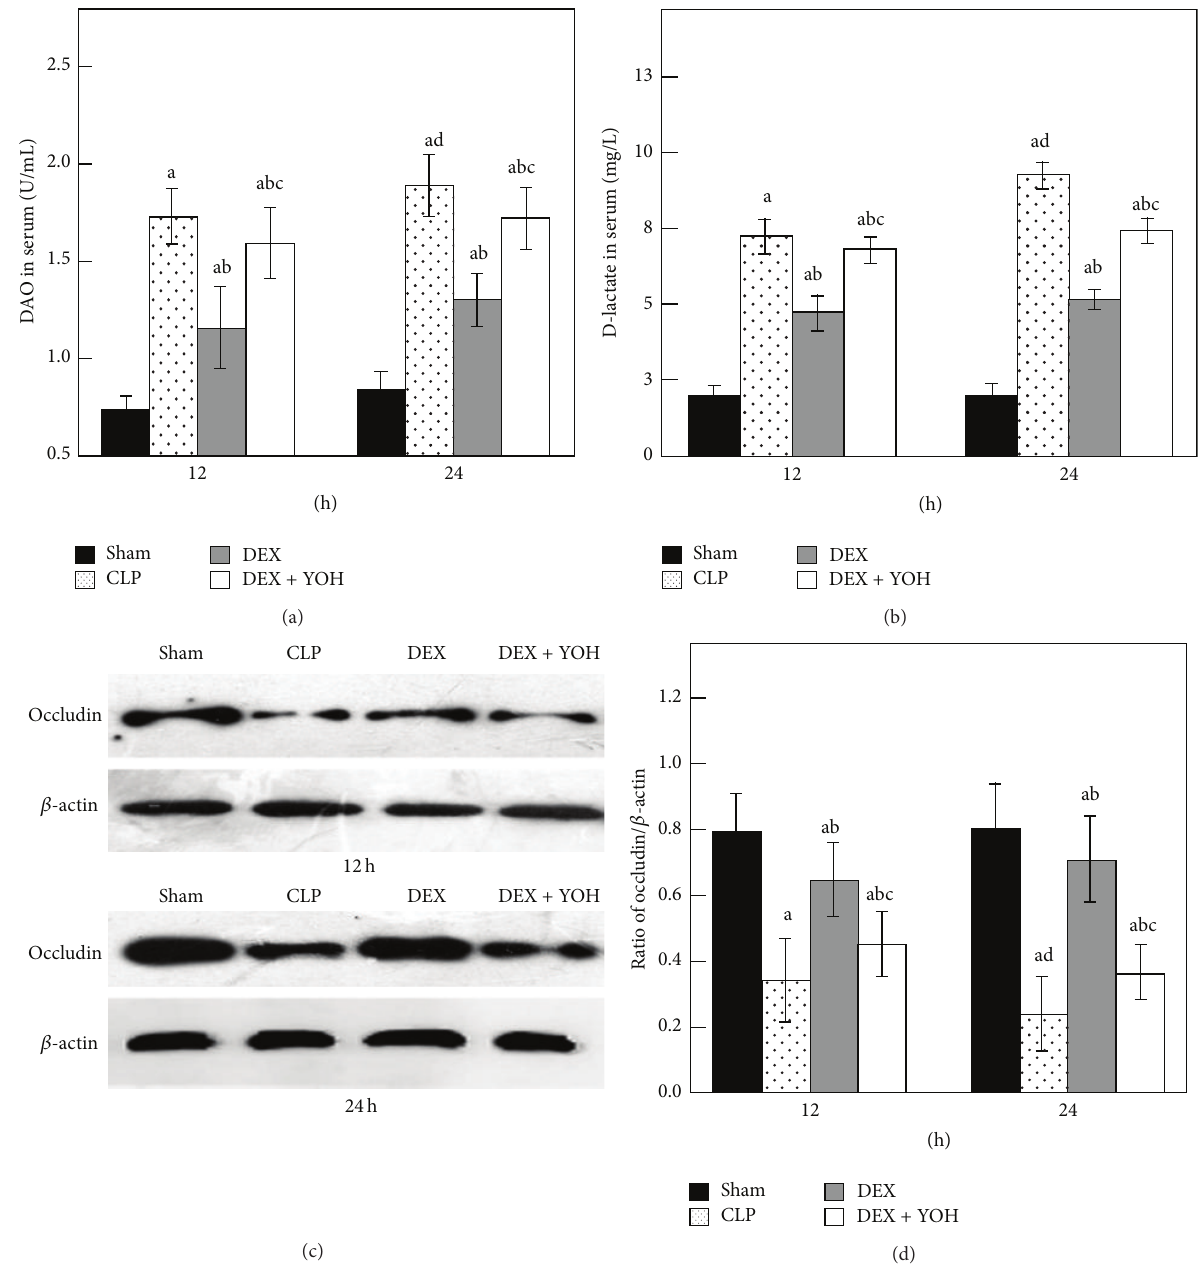
Figure 3: DAO and D-lactate in serum and occludin in intestine in experiment rats among four groups at 12h and 24h ( 𝑛 = 8 ). Data are expressed as mean ± SD. a 𝑃 < 0.05 , versus Sham group; b 𝑃 < 0.05 , versus CLP group; c 𝑃 < 0.05 , versus DEX group; d 𝑃 < 0.05 , versus CLP group 12